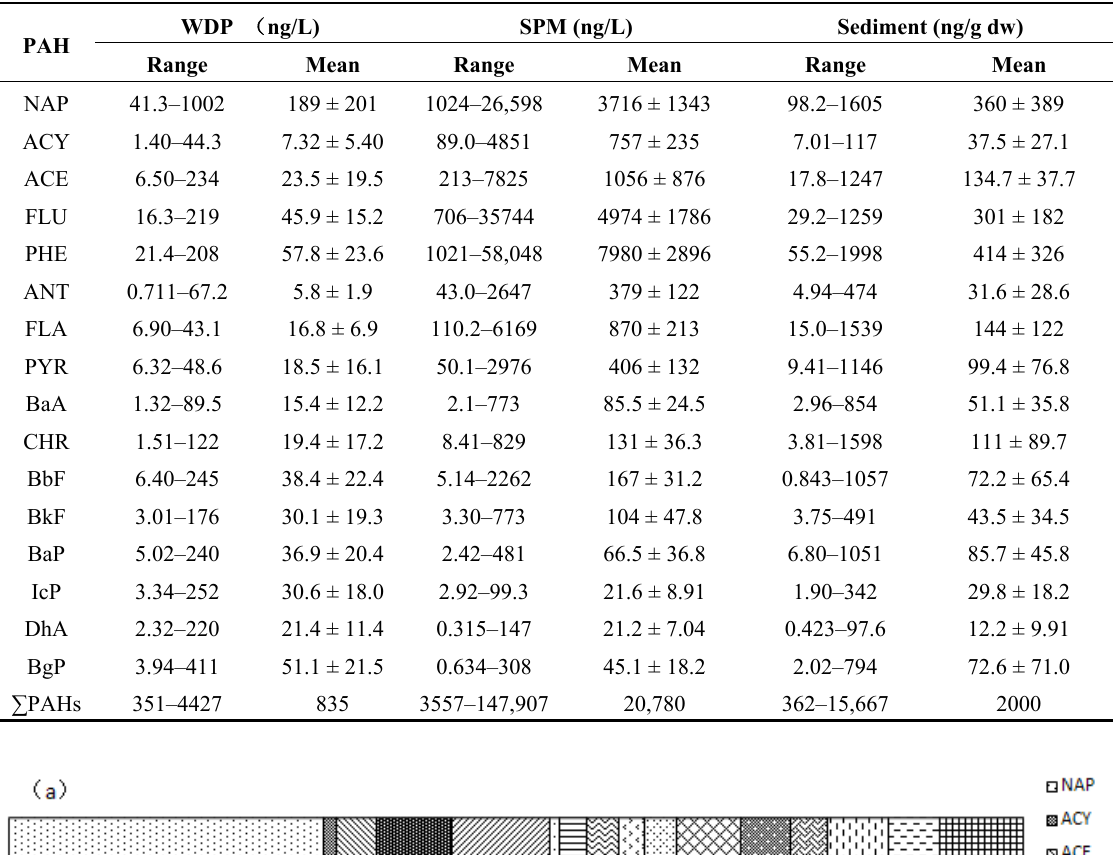
Table 1. Concentration ranges and mean value of polycyclic aromatic hydrocarbon (PAH) in water dissolved phase (WDP), suspended particulate matter (SPM) and sediment samples from Weihe River.